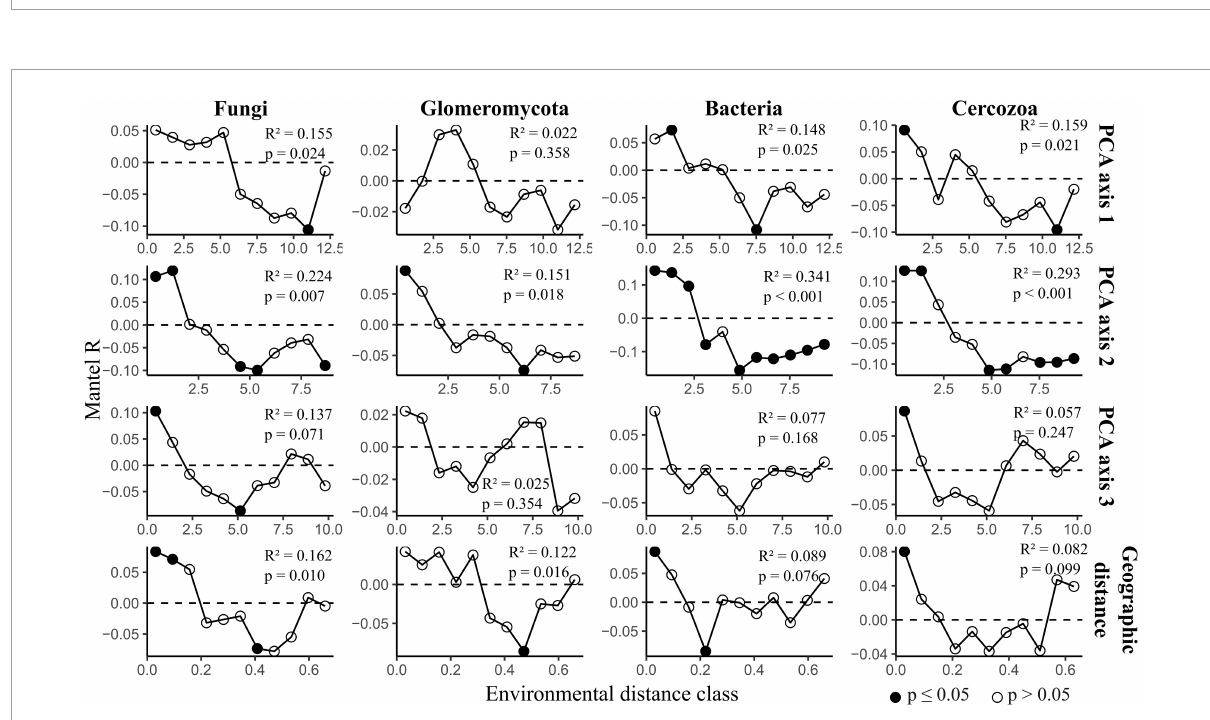
FIGURE4 Distance-decay analysis along environmental gradients across grasslands in Berlin. The figure displays mantel correlograms showing community dissimilarity correlated with environmental and geographic distance. Black points indicate strong evidence for differences between distance matrices ( p ≤ 0.05). The statistical outputs of simple Mantel tests are presented in each plot. The full outputs of simple and partial Mantel tests are reported in Supplementary Table 4